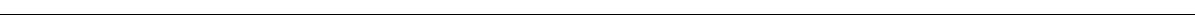
Fig. 3 Global transcription analysis suggests that H1152 treatment upregulated genes involved in mature pancreatic beta cell function. a Heatmap and hierarchical clustering of transcriptional pro fi ling in INS GFP/W HES3-derived INS -GFP + cells treated with H1152 compared to DMSO treated cells. Fetal and adult primary human beta cells were used as controls (GPL11154). b Pathway enrichment analysis on up-regulated or down-regulated genes in INS w/GFP HES3-derived INS-GFP + cells treated with H1152 and adult human islets. c Heatmap of genes in the upregulated pathways, including insulin secretion and type 2 diabetes mellitus. d Heatmap of the genes in the downregulated pathways, including focal adherent and cell cycle. e GSEA of DMSO-treated, H1152-treated INS-GFP + cells and fetal and adult human primary beta cells. The dataset are the gene expression level of DMSO-treated or H1152-treated INS-GFP + cells. The adult beta gene set includes the genes that are > 50-fold higher expressed in adult beta cells compared to fetal beta cells. The fetal beta gene set includes the genes that are > 50-fold higher expressed in fetal beta cells compared to adult beta